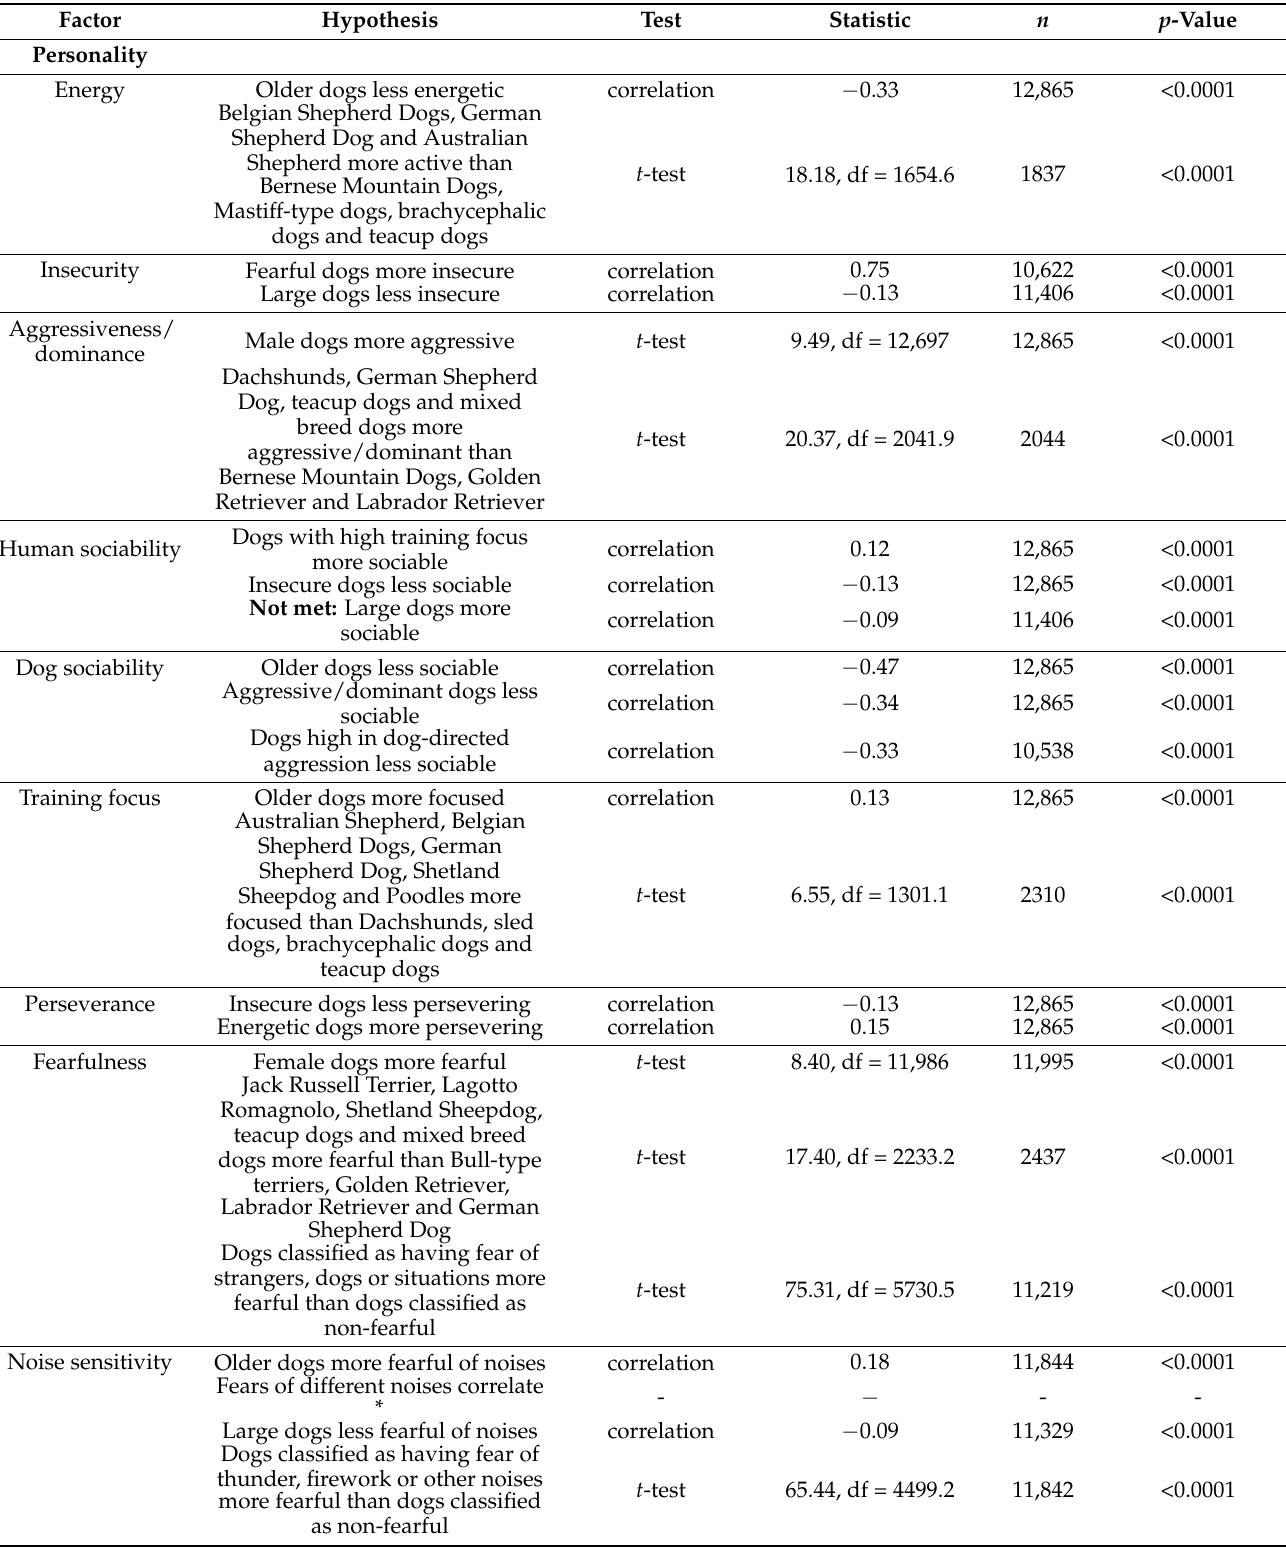
Table 4. Hypotheses formed to examine the convergent validity of the questionnaire, and their Pearson correlation coefficients, t -test statistics, sample sizes, and p -values. All p -values were corrected for false discovery rate